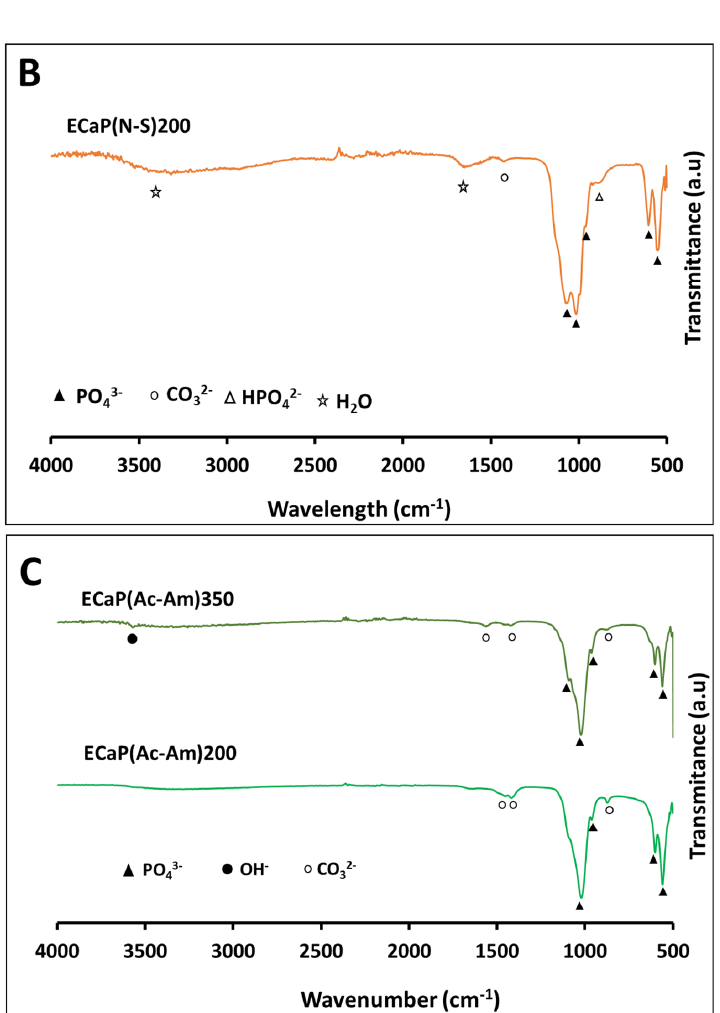
Figure 6. FTIR spectra of samples synthesised at 200 °C and 350 °C at constant pH of 11 and 6 for eggshell solution and struvite solution, respectively, where acid and base solutions were as follows: